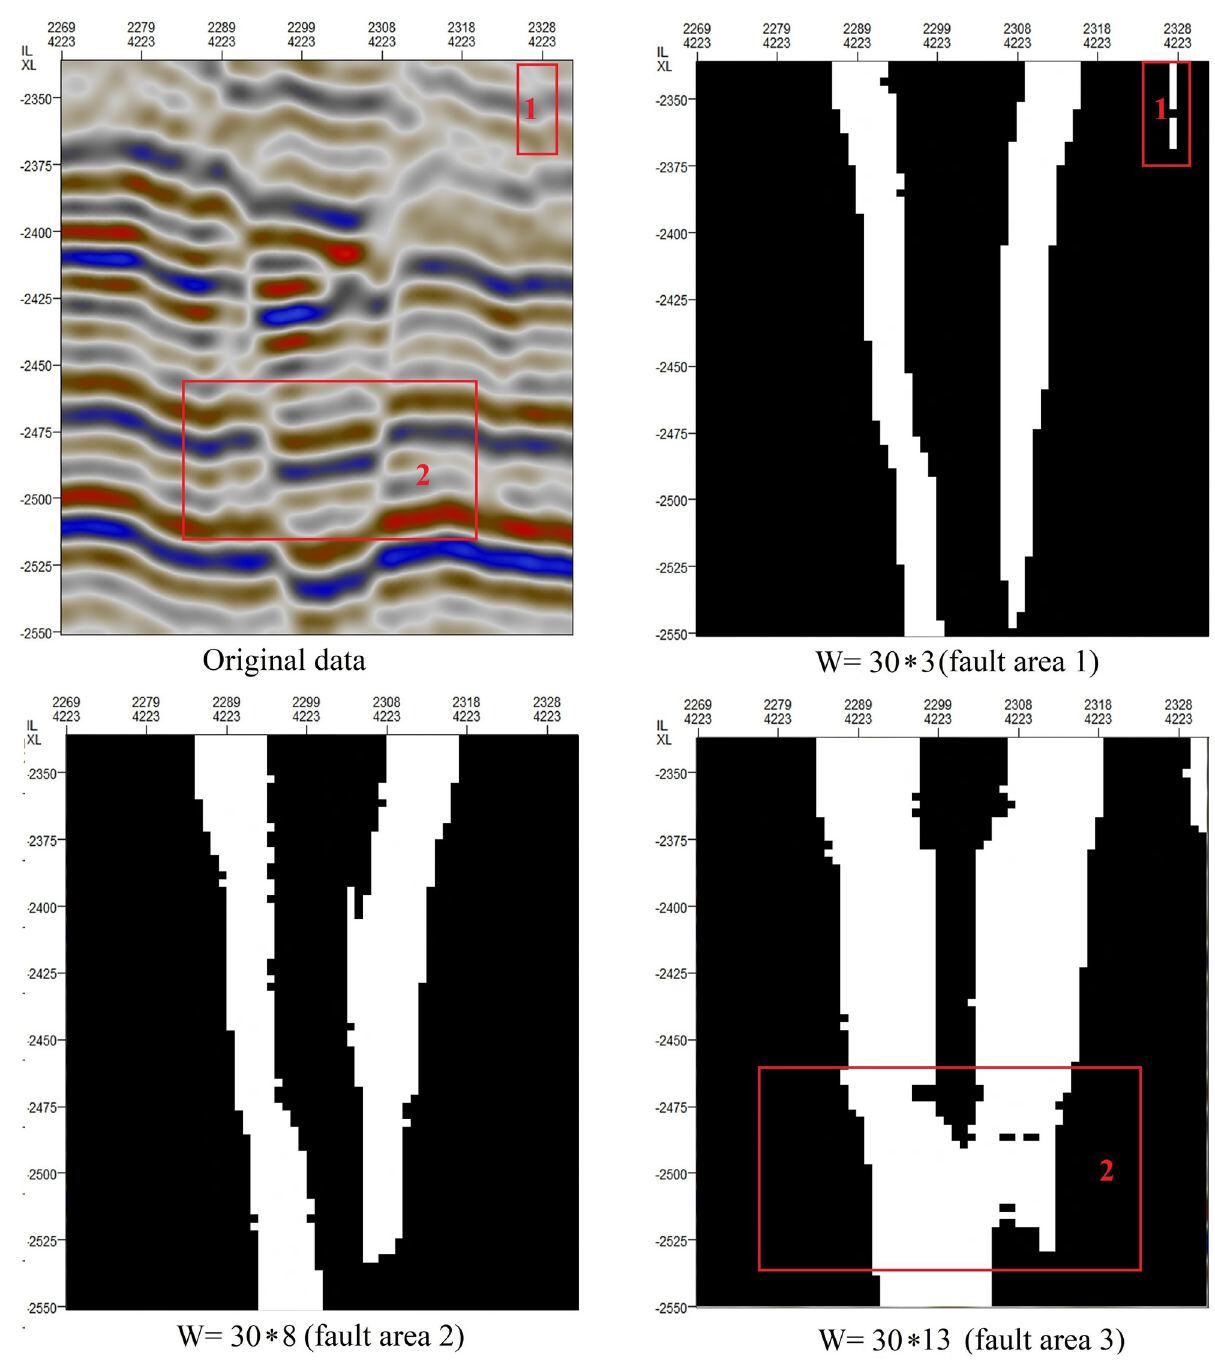
Fig 8. Influence of different values of n in the convolution kernel W on the extracted fault areas.